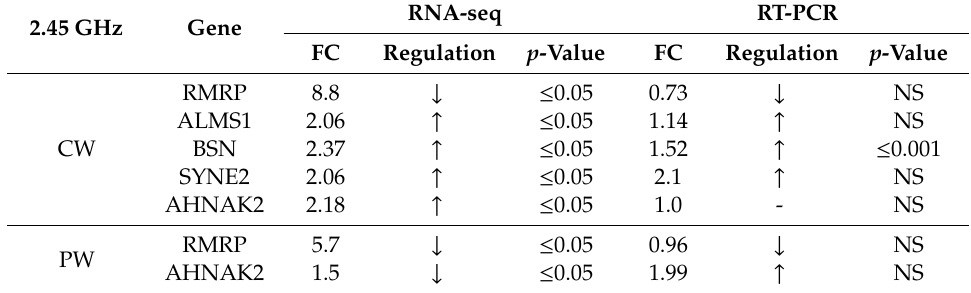
Table 4. In the table, the results obtained from the RT-PCR validation on the selected genes, compared to the results obtained from RNA-seq analysis are reported. The validation was performed on the same RNA used for RNA-seq, and the results are representative of four independent experiments. These genes were di ff erentially expressed 2 h after exposure after CW or PW signals, and results obtained with the exposed cells were compared to the corresponding sham cells (exposed 2 h vs. sham 2 h; t -test). The table includes type of signal, gene name, fold change (FC), direction of change as up-regulation ( ↑ ), down-regulation ( ↓ ) or no changes (-) and p -value. Not significant